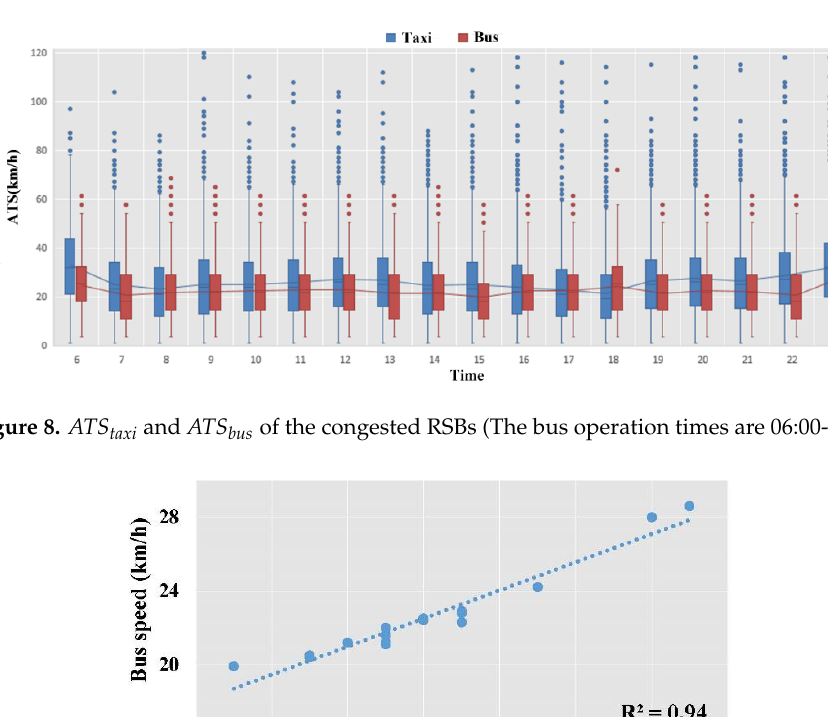
Figure 10. The optimization of route 031. The inset shows the spatial distribution of route 031 stops. Preliminary evaluation criteria according to previous studies [11,26,34]: (1) The number of multiplexed routes: According to the Zhongshan public transport network, the number of multiplexed routes between the Social Security Bureau stop and the Local Taxation